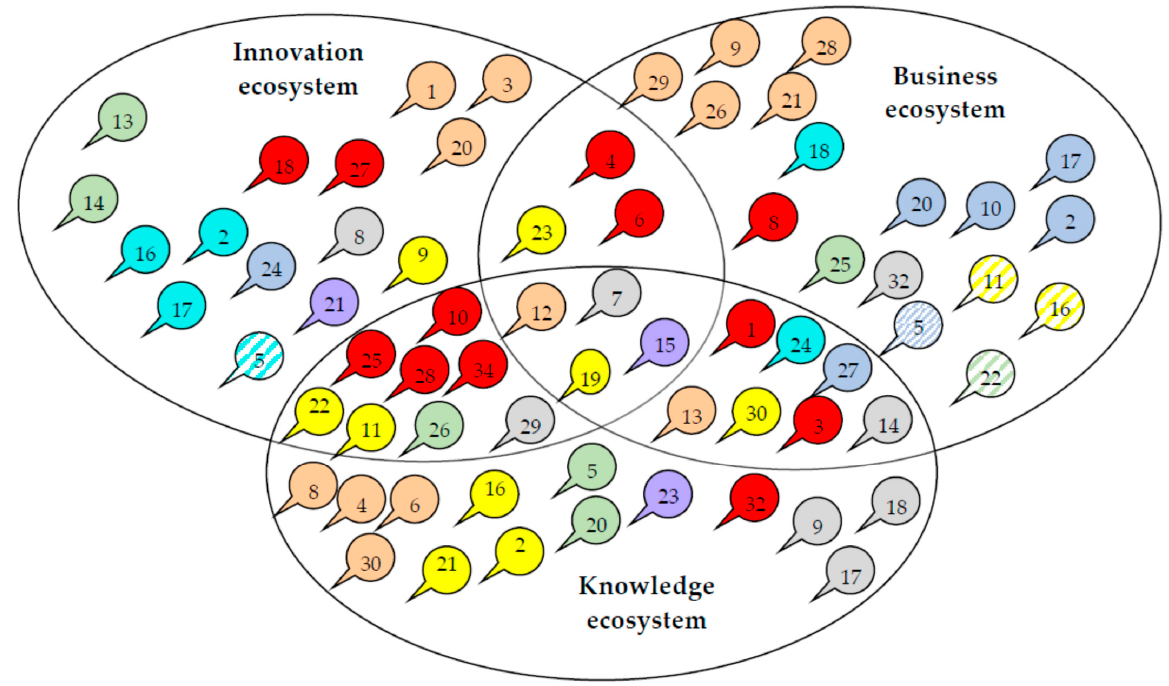
Figure 10. Stakeholders in the multimodal freight transport ecosystem. Each of the studied types of multimodal transport ecosystem has its development leaders. In the business ecosystem, it is the logistics center, intermodal terminal, logistics operator, railway carriers, and inland navigation carrier. These organizations create added value in the multimodal transport ecosystem and at the same time are the most susceptible to fluctuations in the multimodal flows. They also have the potential to directly affect organizations within the supply chain to increase multimodal flow through incentives for manufacturers and trade organizations. Within the business ecosystem, an important role is played by crucial players who also have a significant interest in the development of this ecosystem and at the same time have a high strength of influence on its development. However, their behavior is not unequivocal and predictable like in the case of development leaders. Infrastructure managers or trade and service companies are such participants in this ecosystem. Development leaders in this ecosystem should include in their policy the crucial role of these stakeholders who must be supported in decisions oriented on multimodal transport development. Risk related to the loss of trust of such participants entails major consequences for the whole ecosystem. However, the